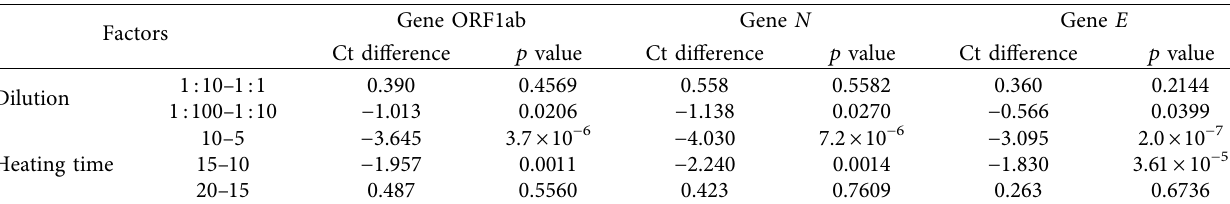
Table 2: Differences in Ct values and respective p values, for factors dilution and heating time, for genes ORF1ab, N, and E, as determined by post hoc Tukey HSD